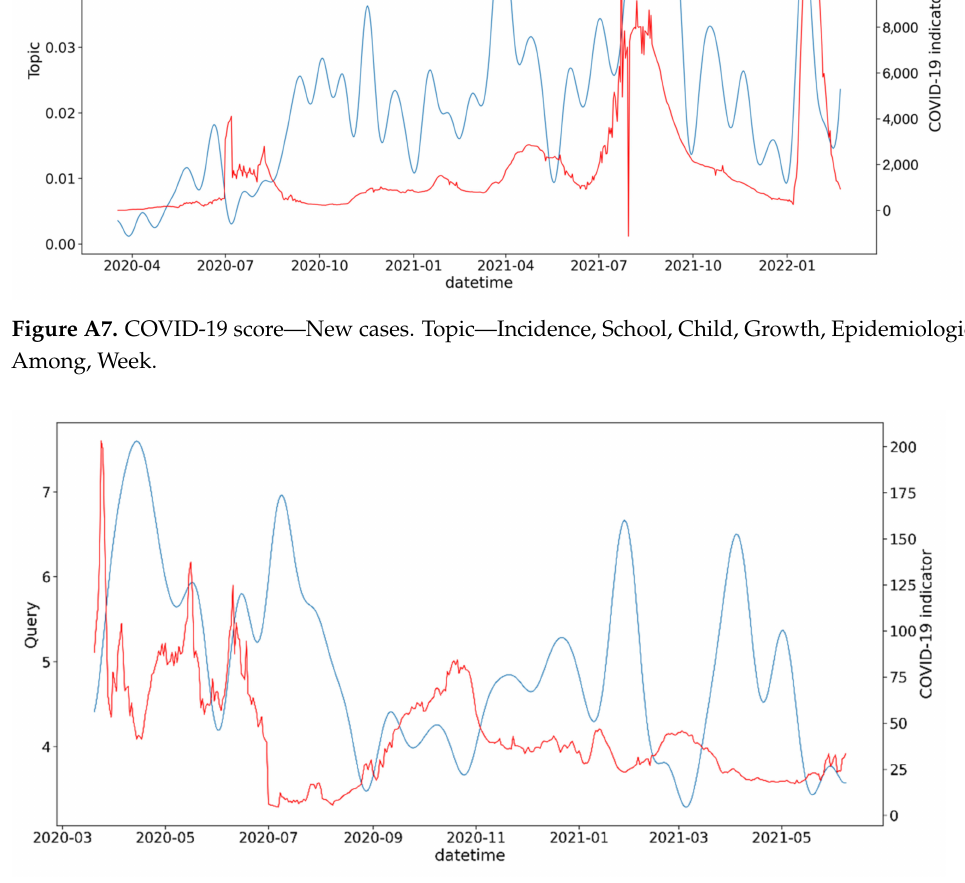
Figure A8. COVID-19 indicator—Tests per case. Query—vaccination COVID-19 vaccination.